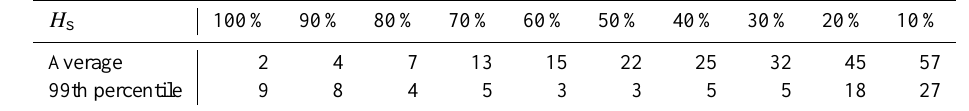
Table 2. MDA-SOM: absolute errors of average and 99th percentile of H s after MDA-SOM relative to the original data set (%).